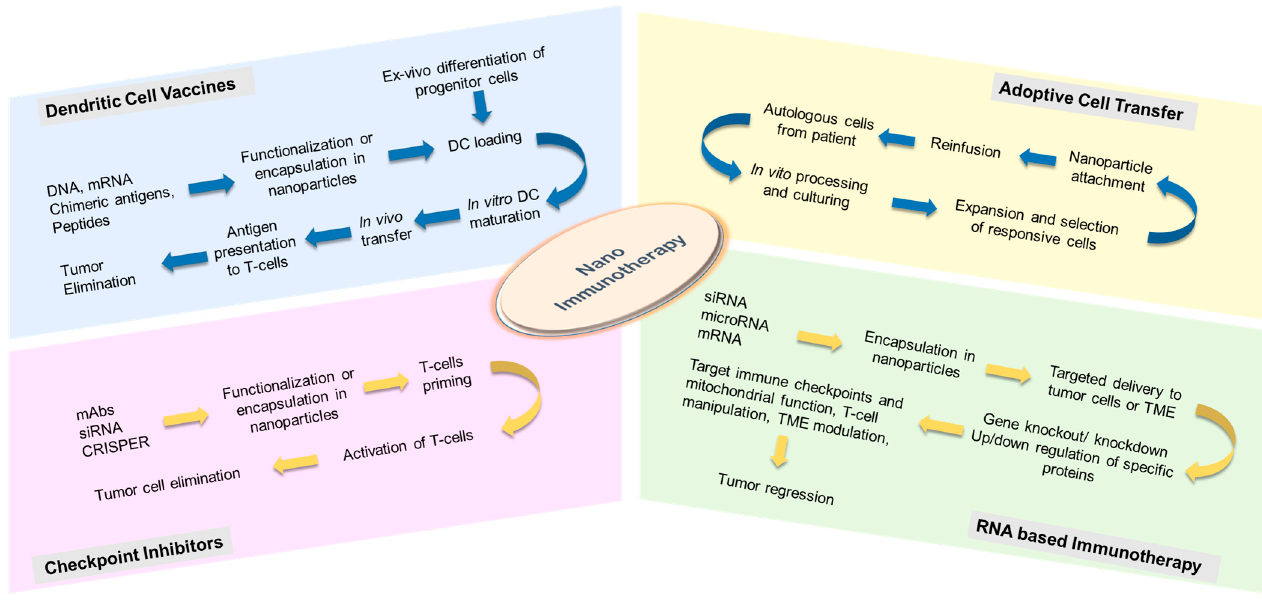
Figure 3. Nanoimmunotherapy interface for cancers: Immunotherapeutics for cancers have used nanomaterials to boost the potential of various immunotherapy techniques such as DC vaccine, adoptive cell transfer, checkpoint inhibition, and RNA-based immunotherapeutics. The basic mechanisms are illustrated.